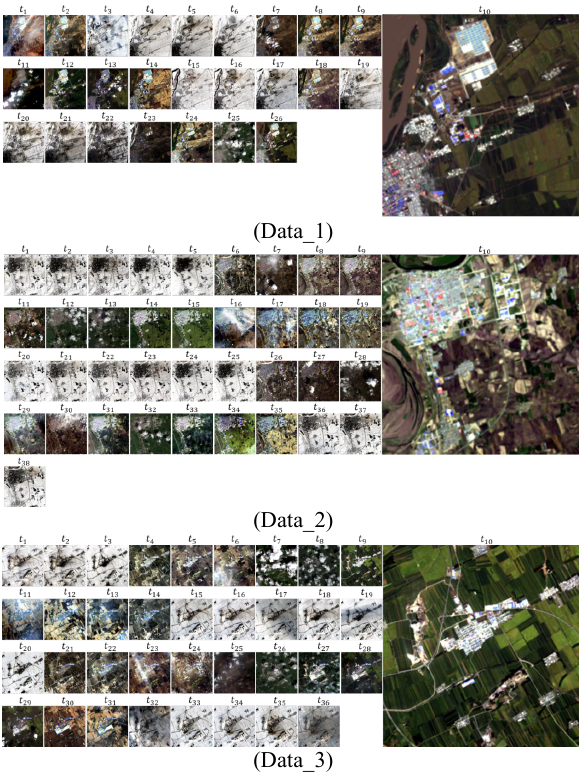
Figure 6. Three typical study areas (Data_1, Data_2 and Data_3) which are mainly based on urban expansion and natural phenology of various crops from 2015 to 2016.